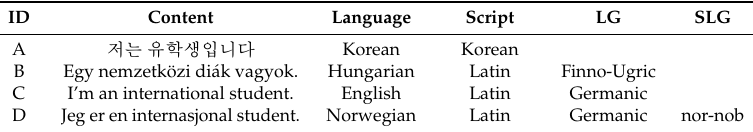
Table 6. Toy example sentences. SLG, similar language